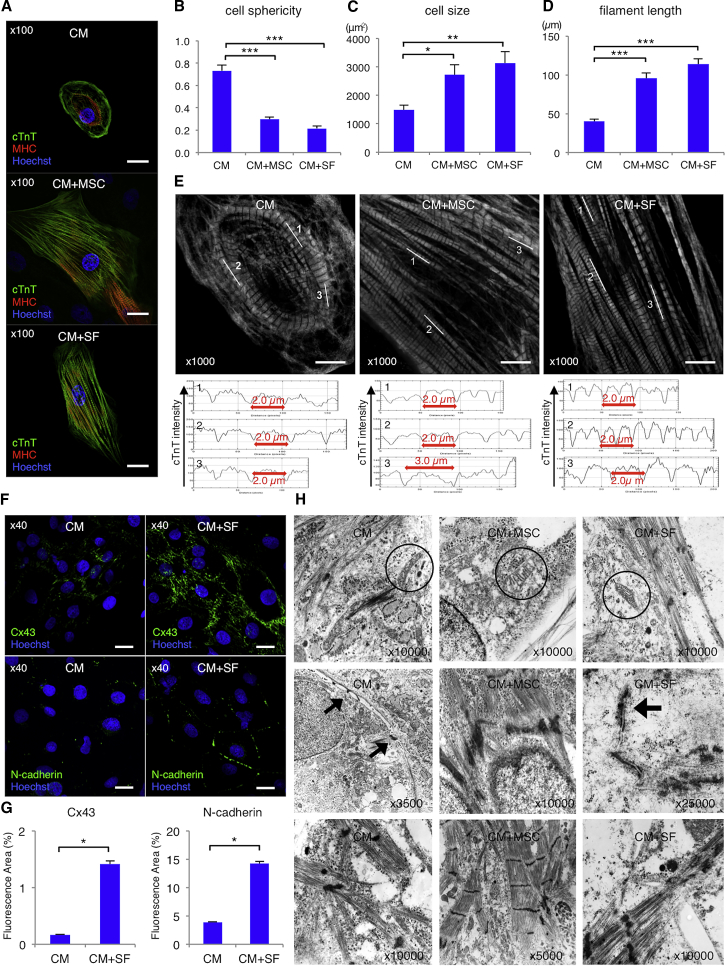
hMSCs Promote Structural Development in hiPSC-CMs(A) Immunohistochemistry of cardiac troponin T (cTnT; green), myosin heavy chain (MHC; red), and nuclei (Hoechst33258; blue) in differentiated cardiomyocytes (CM), cardiomyocytes co-cultured with mesenchymal stem cells (CM+MSC), and cardiomyocytes cultured with MSC-derived soluble factors (CM+SF). Scale bars: 30 μm. (B–D) Cell sphericity (B), cell size (C), and filament length (D) in the CM, CM+MSC, and CM+SF groups (n = 7 for each group). *p < 0.05; **p < 0.01; ***p < 0.001, one-way ANOVA with post hoc Tukey’s honestly significant difference (HSD) test. (E) Upper panels display immunohistochemistry of cTnT (white) in the CM, CM+MSC, or CM+SF groups through super-resolution microscopy. Lower panels show the intensity of cTnT at the white lines in the above images. Scale bars: 10 μm. (F) Upper panels show immunohistochemistry of connexin 43 (Cx43; green) and Hoechst33258 (blue) in the CM and CM+SF groups. Lower panels show immunohistochemistry of N-cadherin (green) and nuclei (Hoechst33258; blue) in the CM and CM+SF groups. Scale bars: 20 μm. (G) Percent of fluorescence area, which was stained with Cx43 and N-cadherin, in the CM and CM+SF groups (n = 4 for each group). *p < 0.05, Student t test. (H) Transmission electron microscopy images of cardiomyocytes in the CM, CM+MSC, and CM+SF groups. For all experiments, results are shown as mean + SEM.